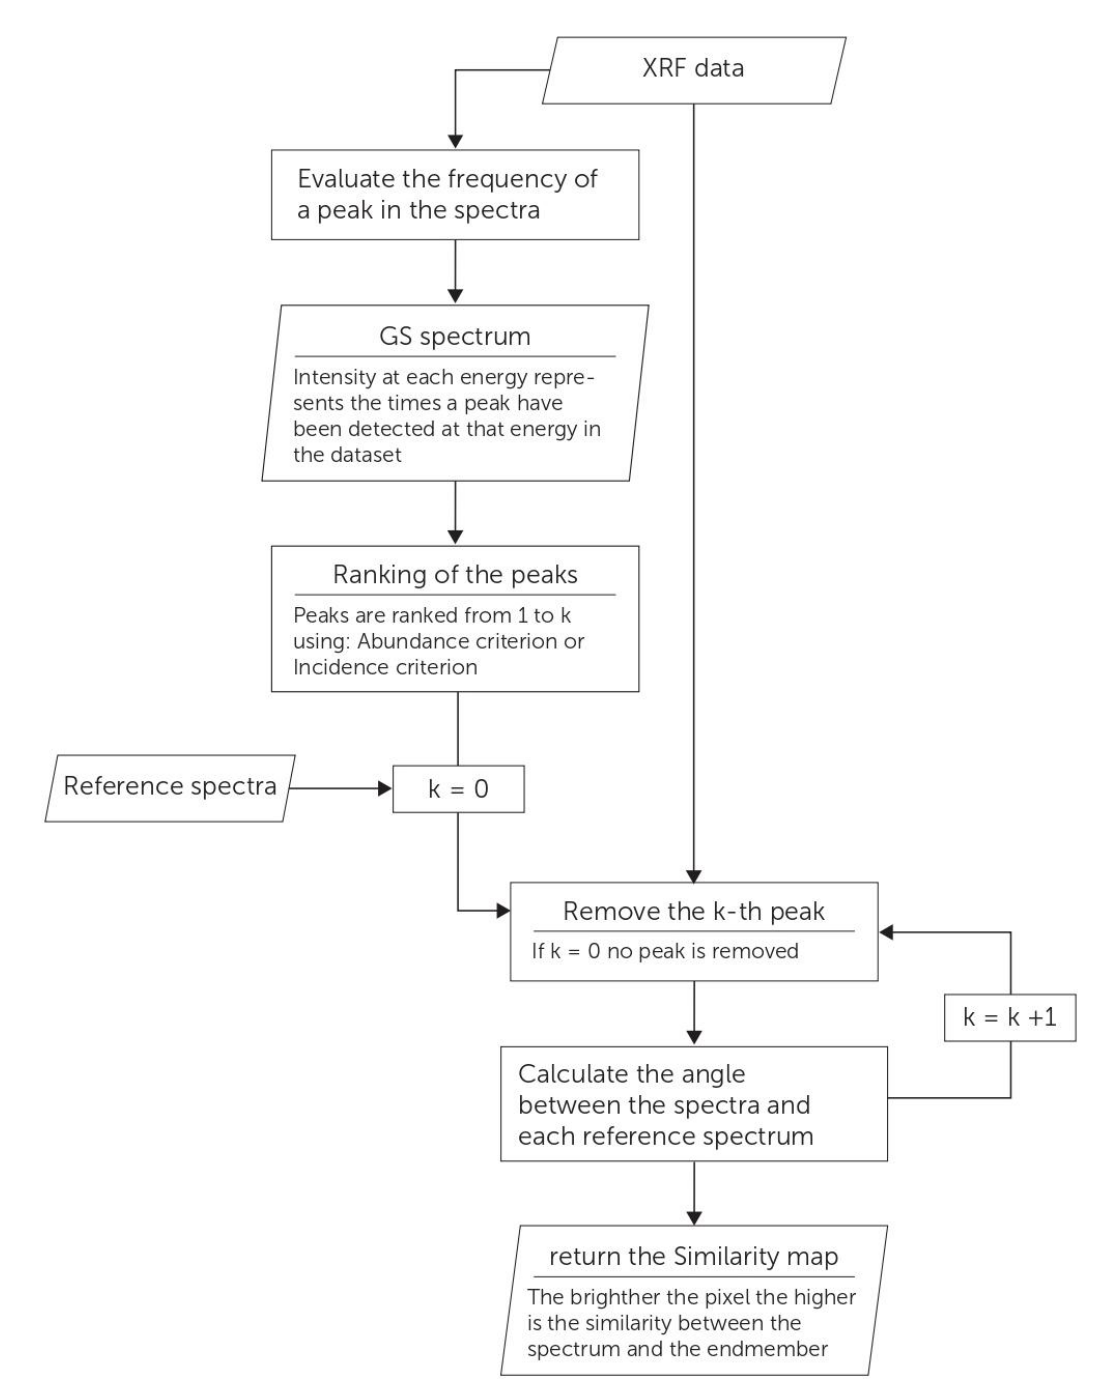
Figure 3. Statistically Tailored Elemental Angle Mapper (STEAM) flow chart.